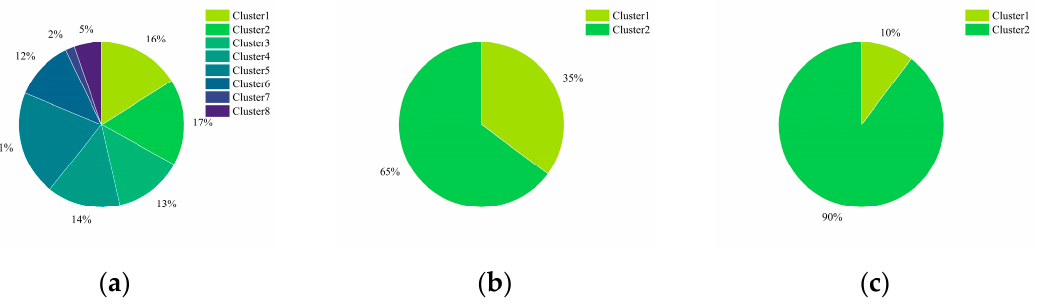
Figure 9. The accounted percentage of different heating patterns in Shandong’s living rooms (( a ). Early heating period; ( b ). mid heating period; ( c ). late heating period).